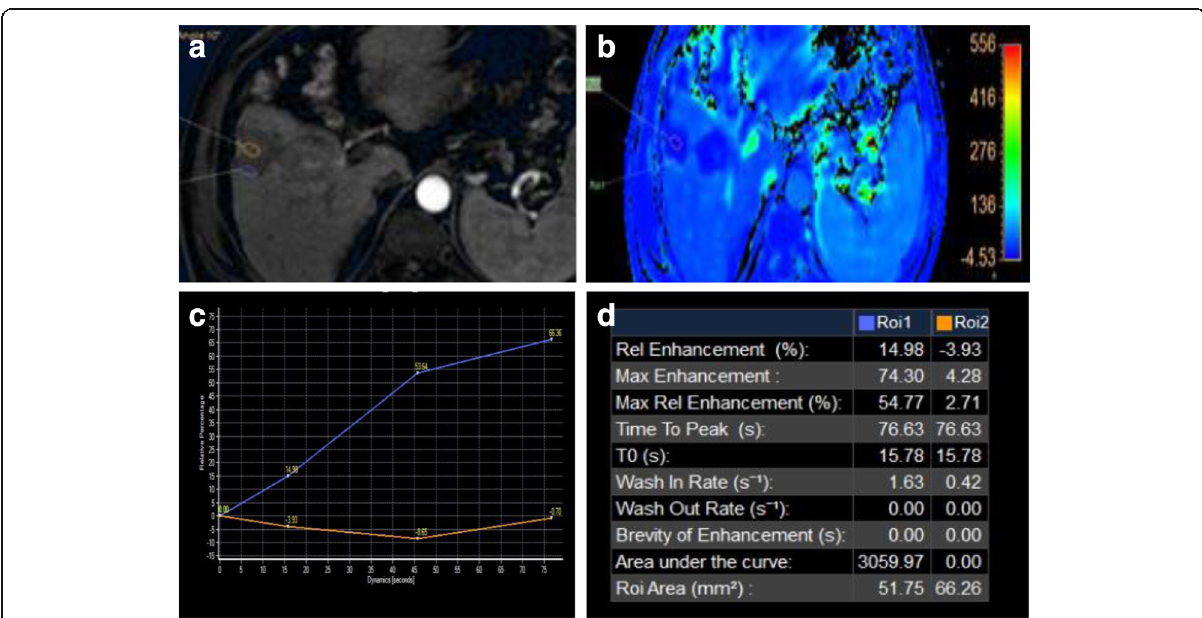
Fig. 13 Two hepatic focal lesions after RFA. a Subtracted enhanced T1-WI in the arterial phase shows faint enhancement of the periphery of the treated HFLs (ROI 1 “ blue ” ) compared to the center of HFLs (ROI 2 “ orange ” ). b T1 perfusion map (max. relative enhancement) shows mild increased blood flow peripherally. c Time-intensity curves on the periphery of the treated HFLs (blue) and their center (orange) show an uprising slope due to inflammation. d Semi-quantitative data for both ROIs show significant decreased max. relative enhancement of the center of treated HFLs compared to the periphery. Final diagnosis is LR-TR nonviable with post-therapy changes